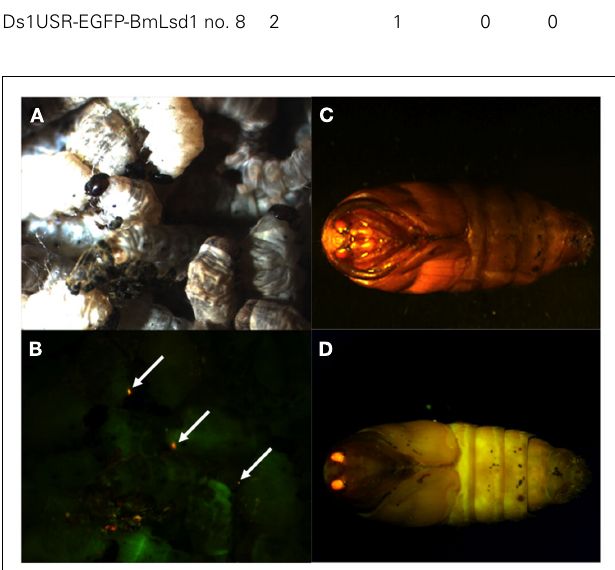
FIGURE 3 | DsRed expression in G 1 transgenic animals. DsRed expression was visible in the stemmata of larvae (A,B) and the compound eyes of pupa (C,D) . (A,C) Bright-field images. (B,D) Fluorescence images. Arrows indicate DsRed expression in the stemmata.